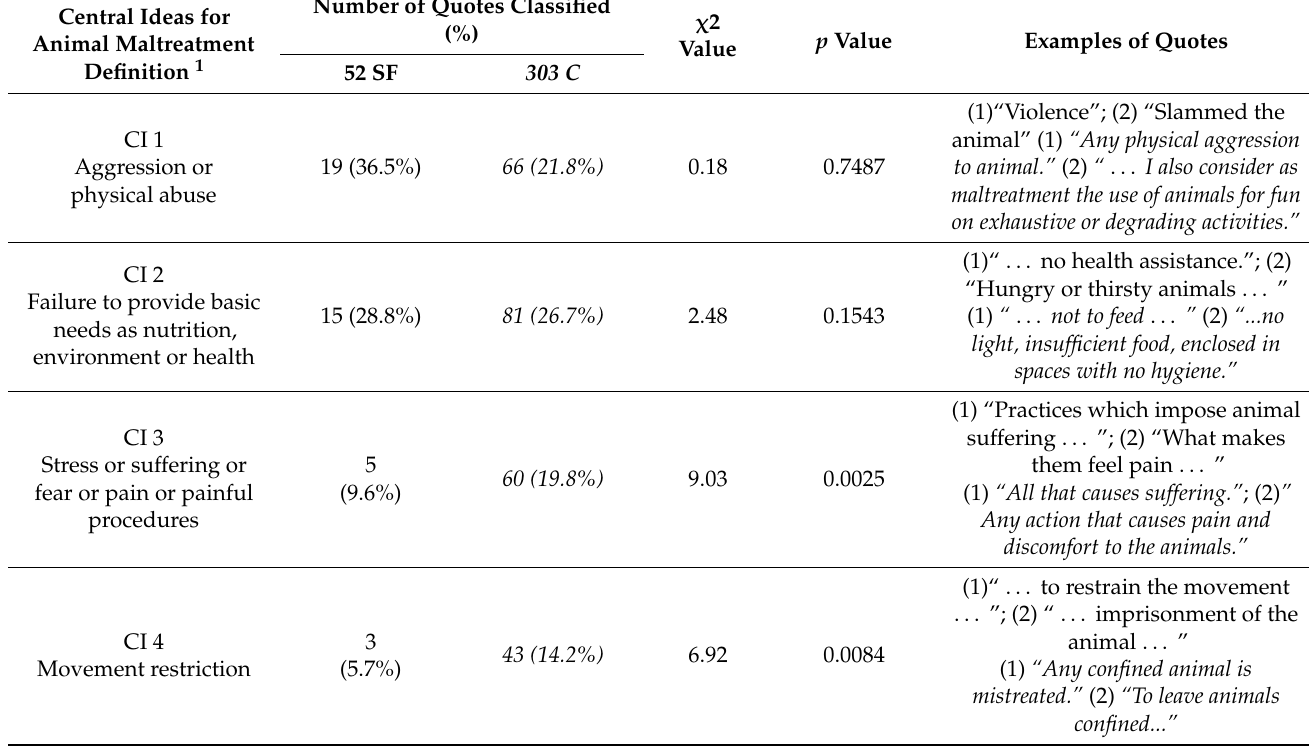
Table 4. Central ideas (CI) on what constitutes animal maltreatment by sheep farmers (SF) in a southwestern town in the State of Rio Grande do Sul, and citizens (C, in italic) in Porto Alegre, the State capital, Brazil, from September to December